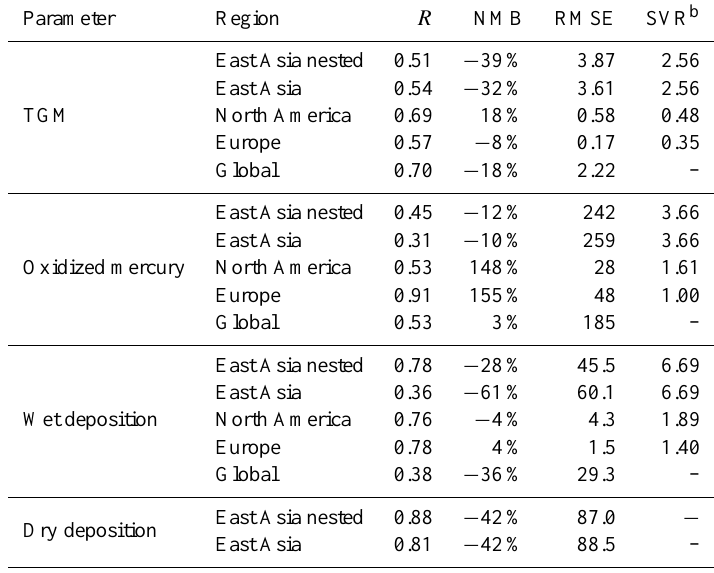
Table 3. Statistical summary of comparisons of the model results with observations a .